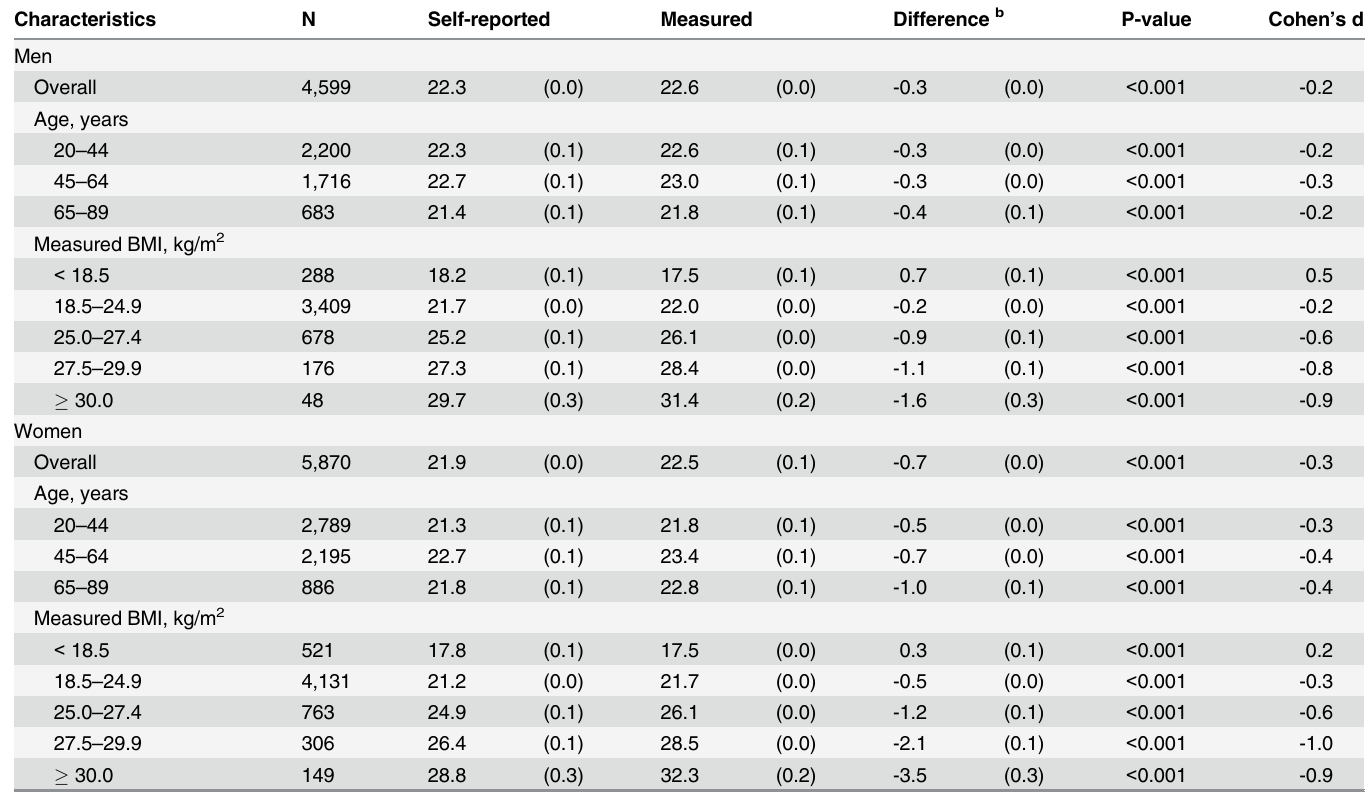
Table 3. Differences between self-reported and measured means of body mass index based on the National Nutrition Survey, 1986 a